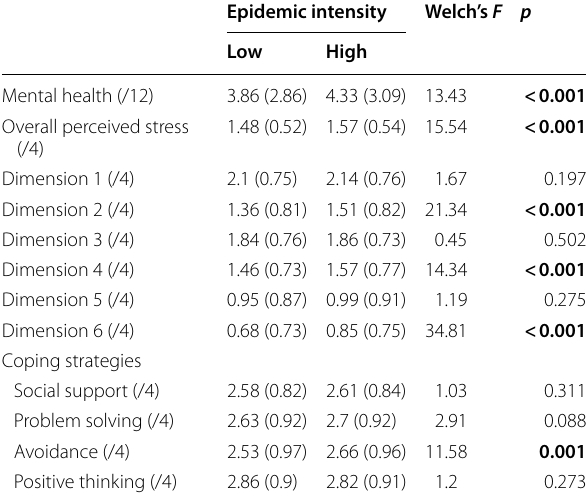
Table 2 Average scores on the study questionnaires among all